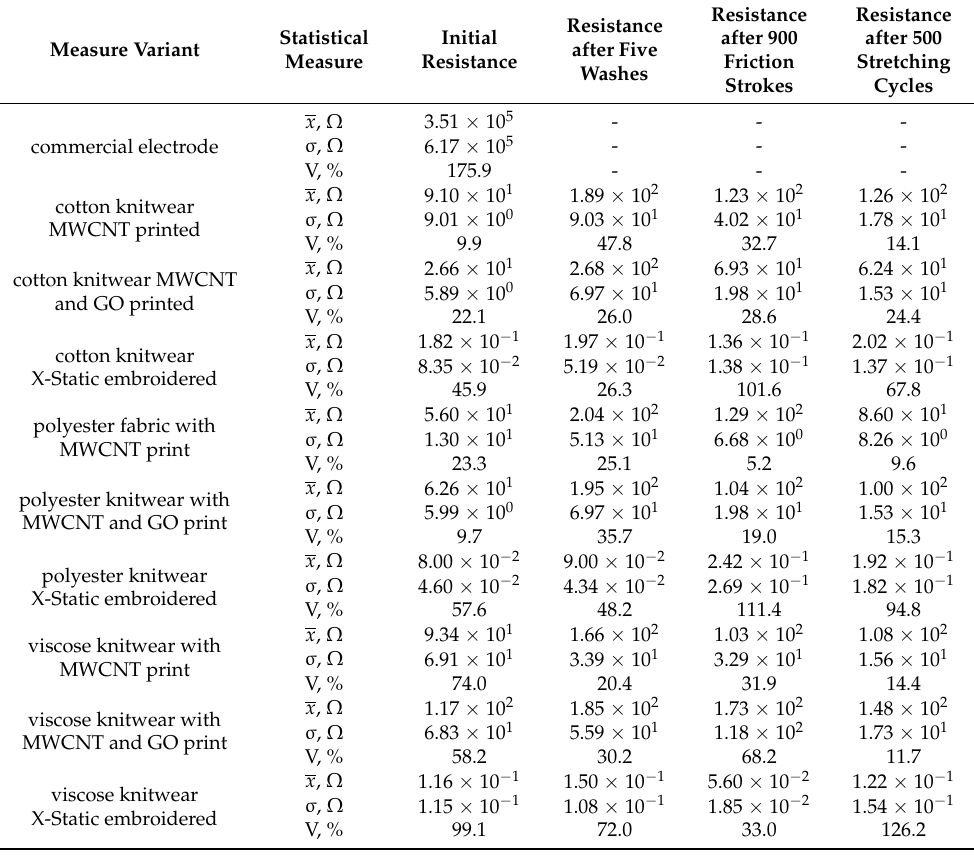
Statistical Measure